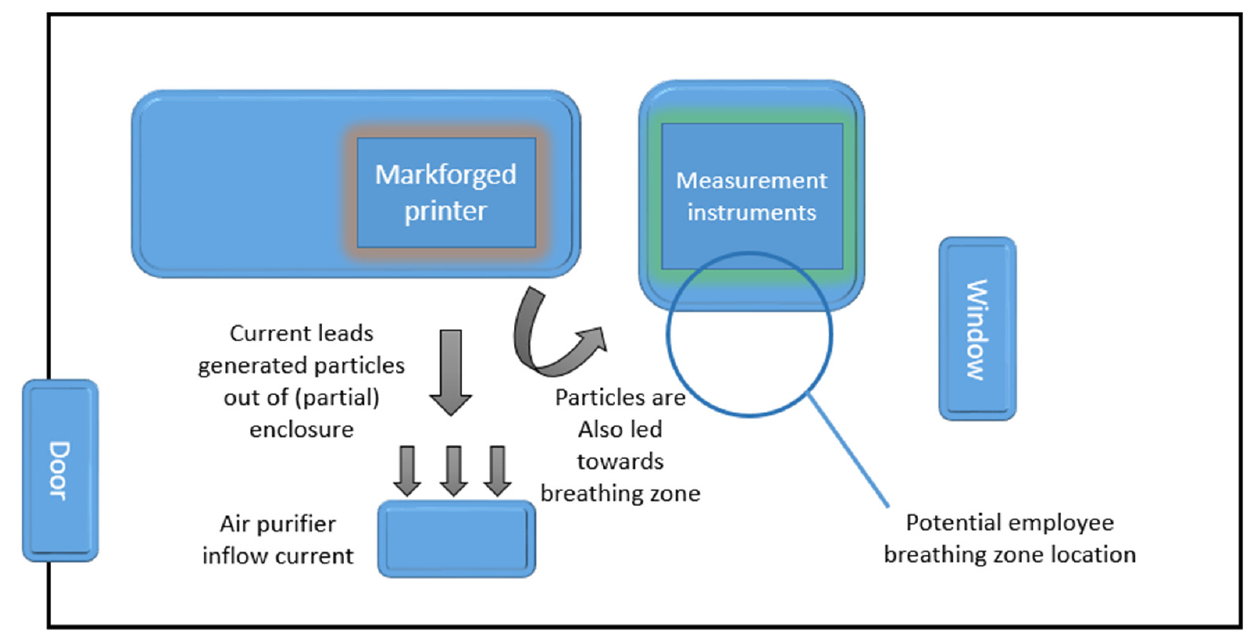
Figure 6. Potential interpretation of increased concentrations after control use in Case 2.